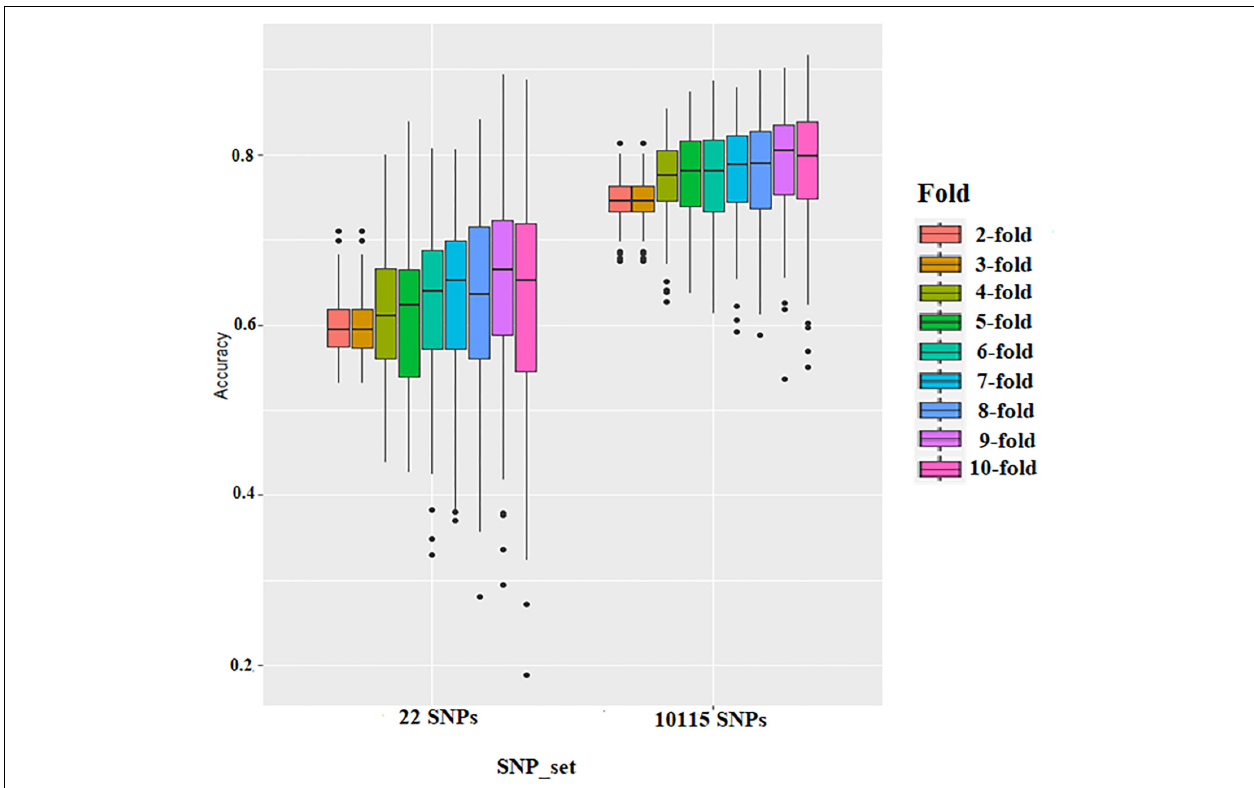
FIGURE 5 | Boxplots show the effect of training population size on genomic selection accuracy by conducting cross-validation at different folds with 100 replications for each cross-validation fold using